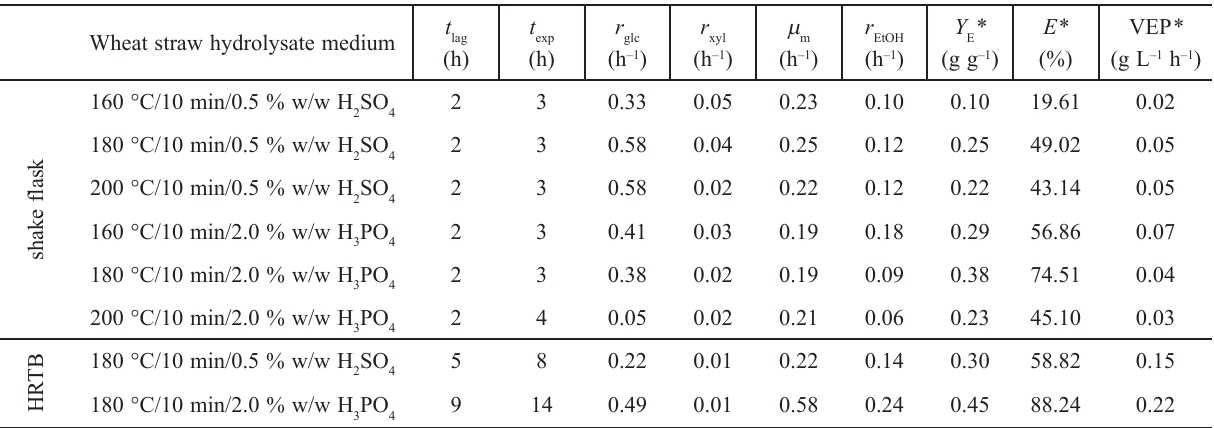
Table 4 – Bioprocess efficiency parameters of the anaerobic cultivation of S. cerevisiae yeast on the liquor wheat straw hydrolysate media in shake flasks and HRTB t Wheat straw hydrolysate medium